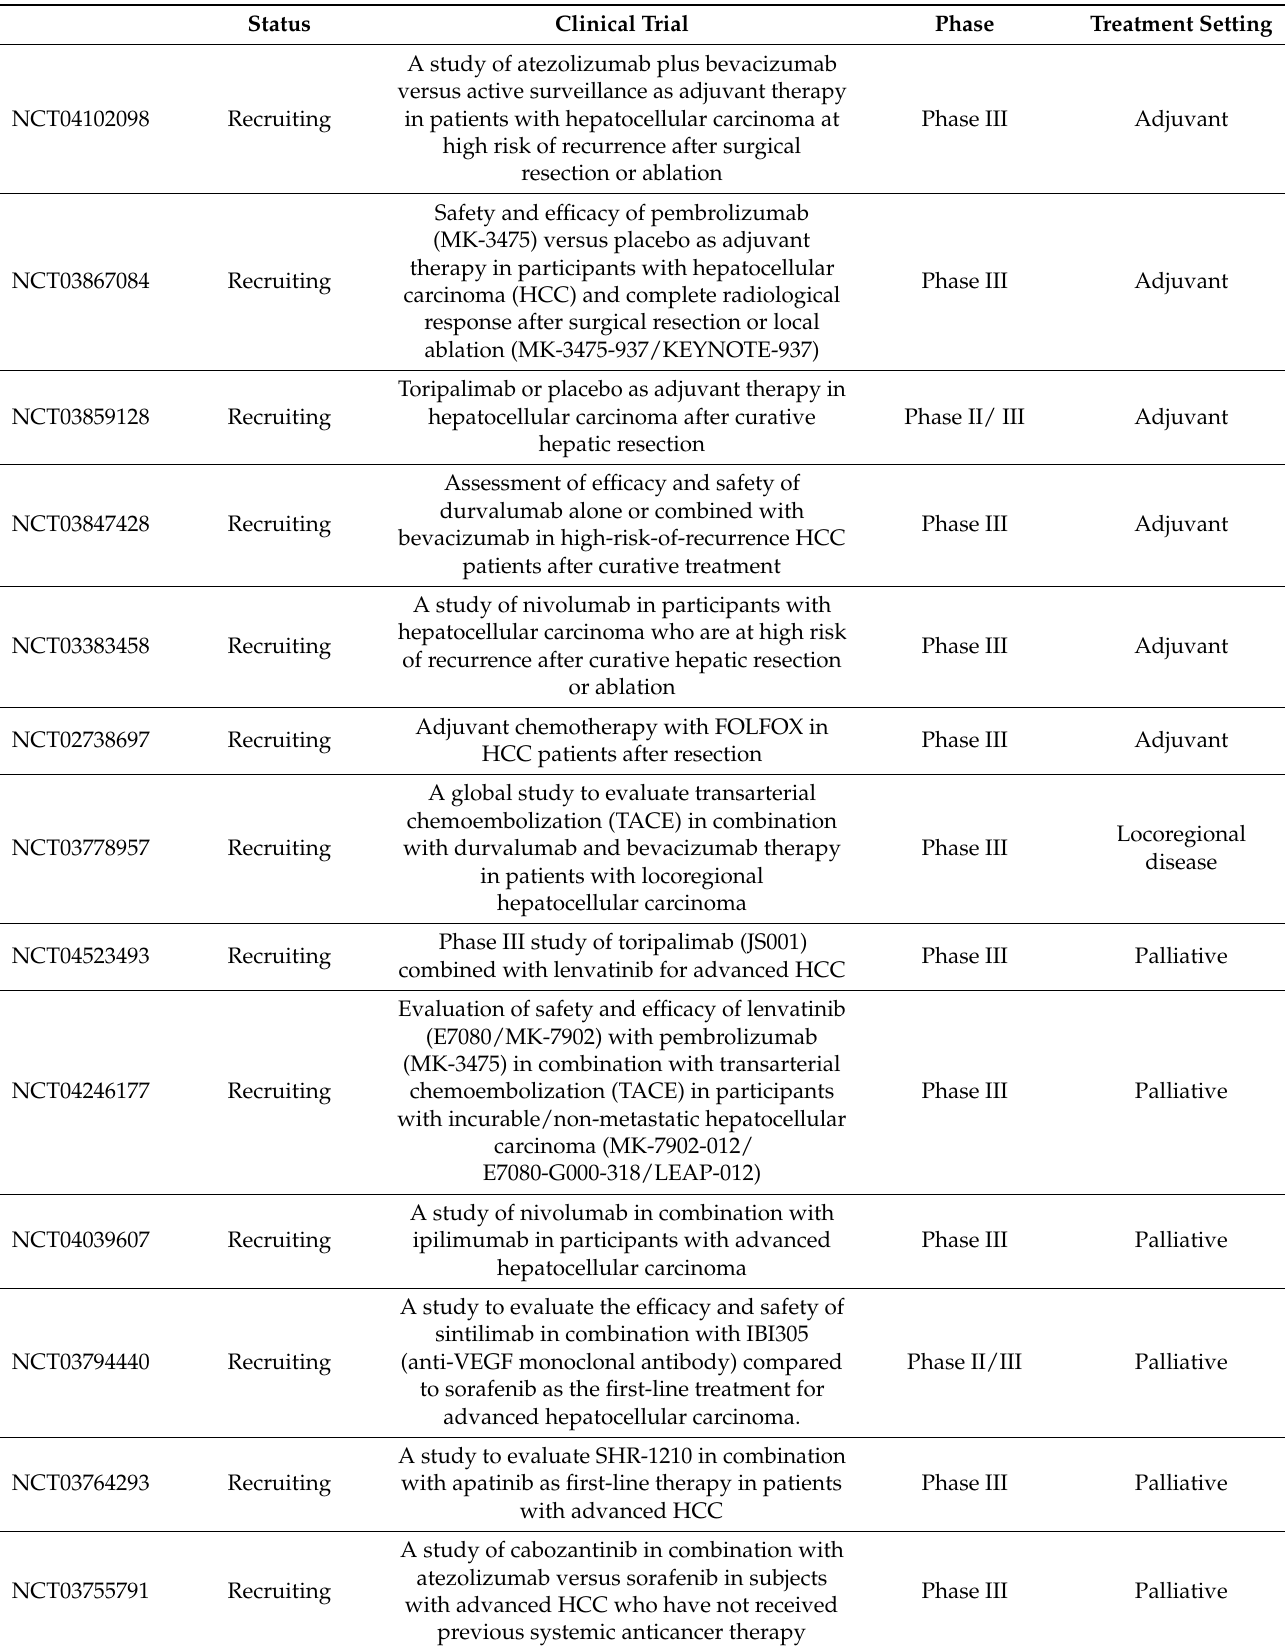
Table 1. Ongoing phase III clinical trials in different treatment setting